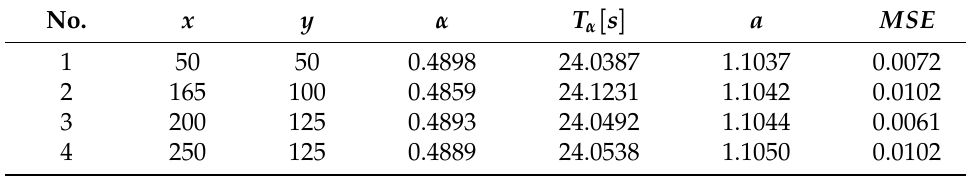
Table 3. Parameters of the FO